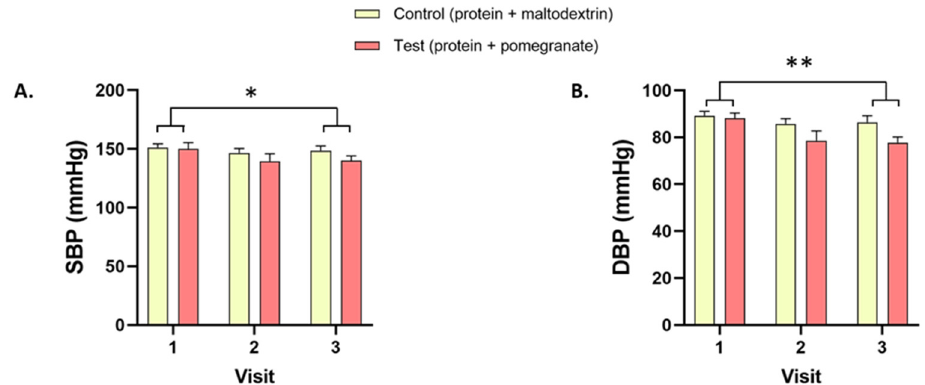
Figure 2. Systolic and diastolic blood pressures. ( A ) Systolic (SBP) and ( B ) diastolic (DBP) blood pressures in the Test and Control groups at V1, V2, and V3. * p < 0.05, ** p < 0.01.